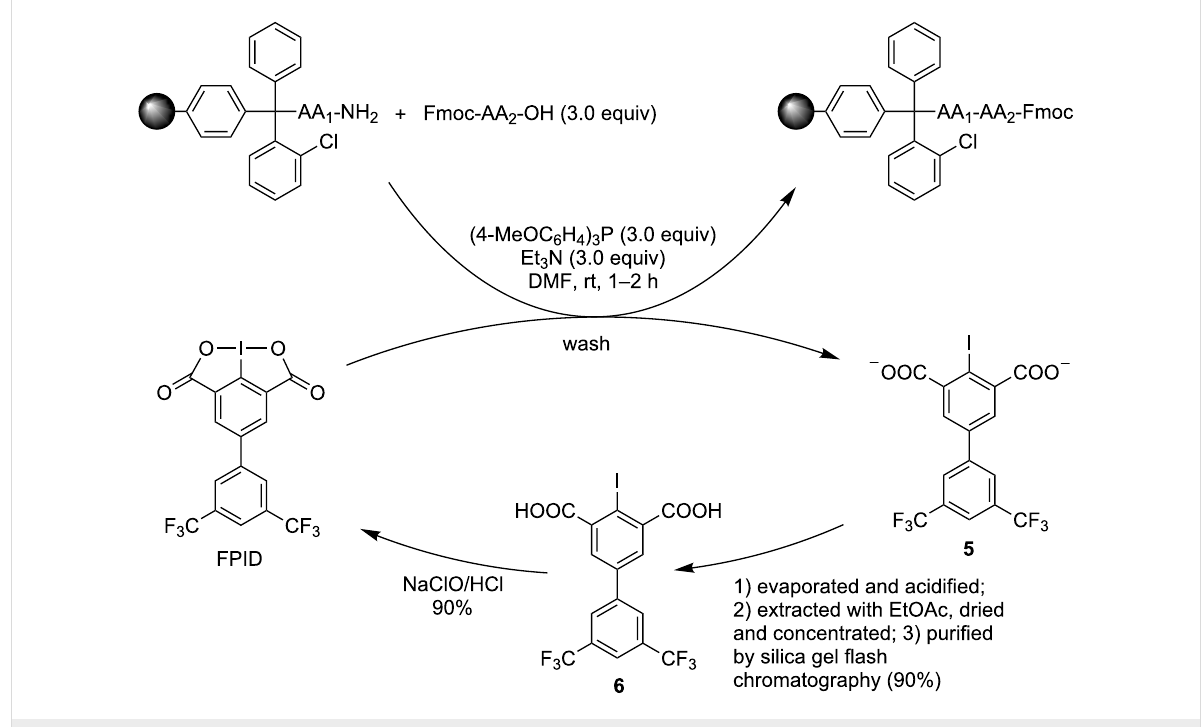
Scheme 3: The regeneration of FPID after SPPS.